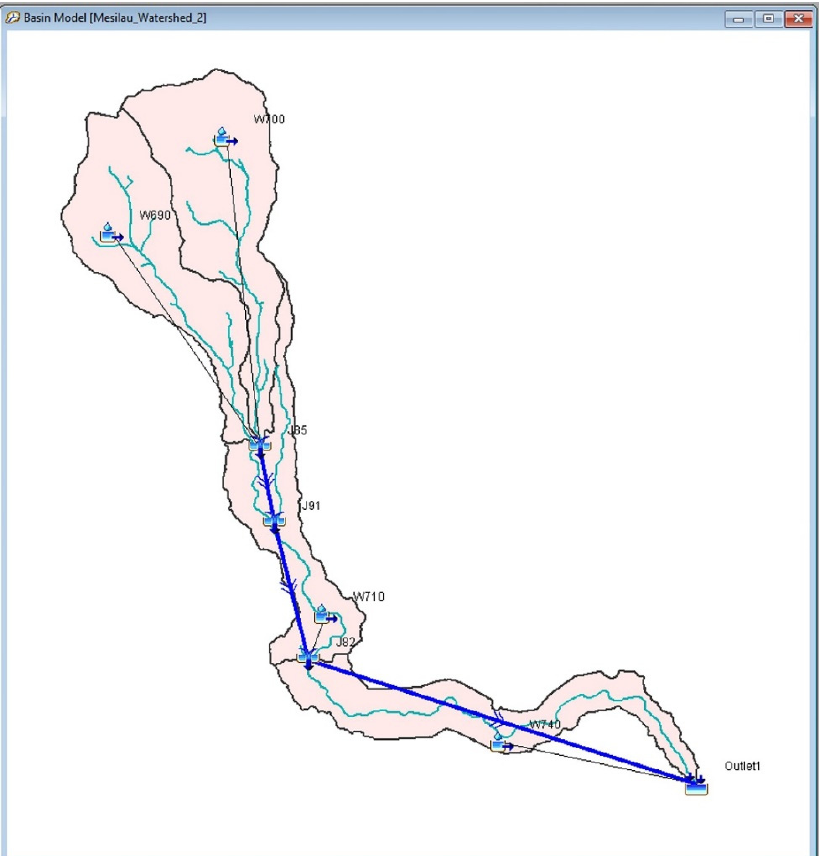
Figure 9. The extracted DTM of the watershed area covering from the upstream to the downstream area, with yellow dots along the channel representing the distance of debris flow runout for every 100 m.